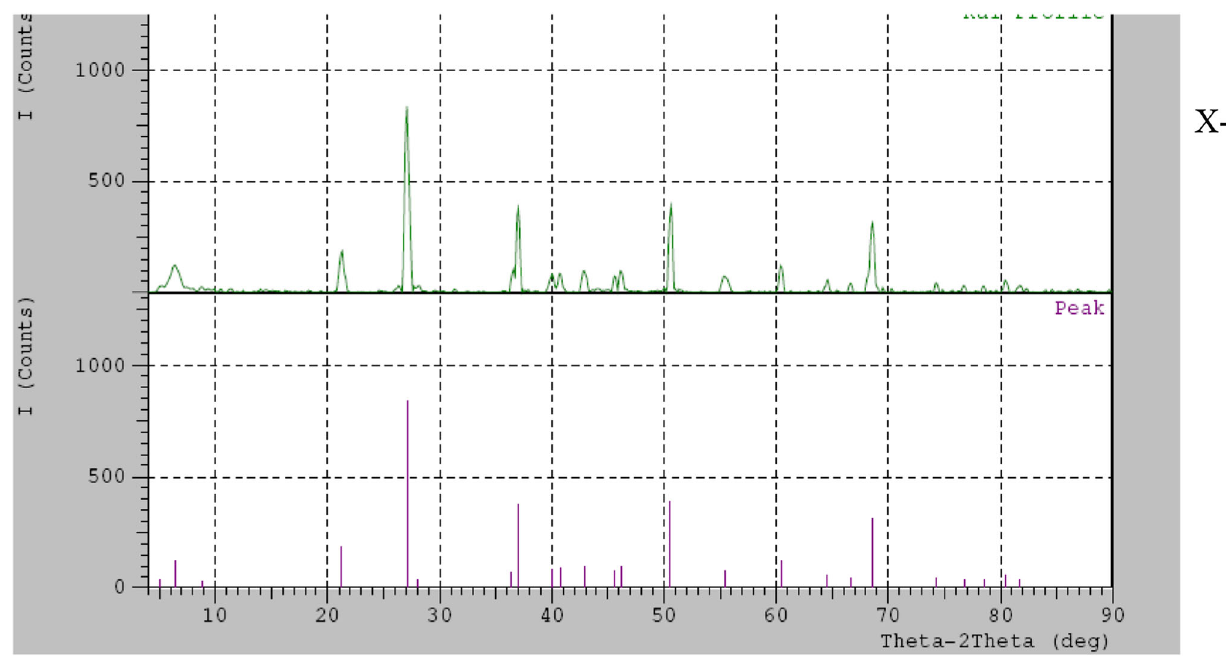
Fig. 7 X-ray diffraction (XRD) of the sample (Conc.4) Table 3 Microstructure of the coated MOCP on the sand before and after filtration using XRD results Nano-sized Average crystallite MOCP c-sand size (nm) before